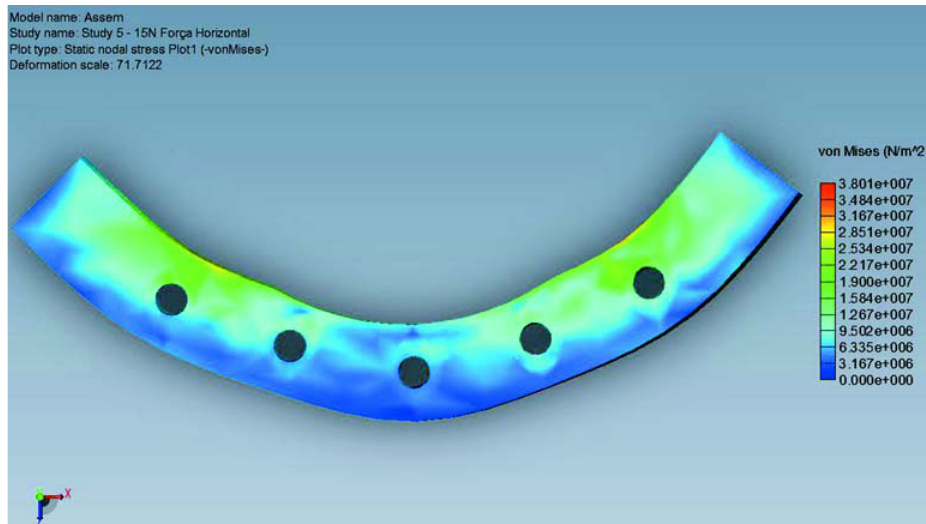
FIGURE 4- Bilateral balanced occlusion, anterior